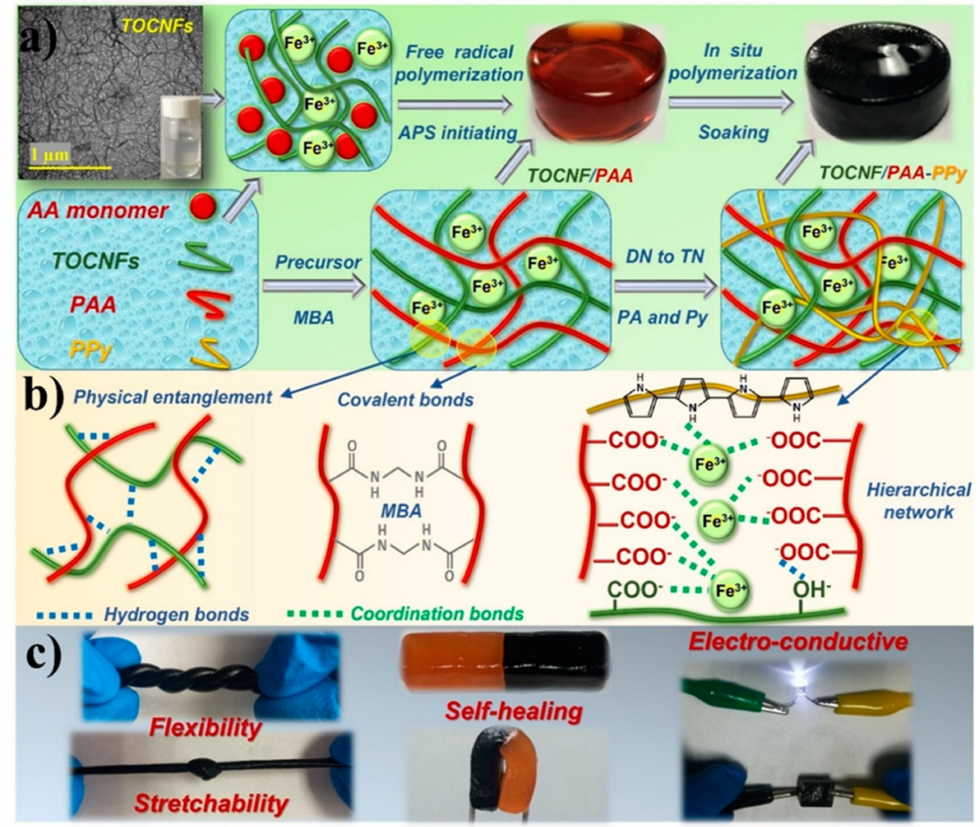
Figure 11. ( a ) Process of fabrication of the composite hydrogels. ( b ) Chemical and physical inter- actions are responsible for the formation of the triple network of the hydrogel. ( c ) Presentation of mechanical properties, self-healing characteristics and conductivity of the composite hydrogels. (Chen). Reprinted with permission from reference [105]. Copyright 2019